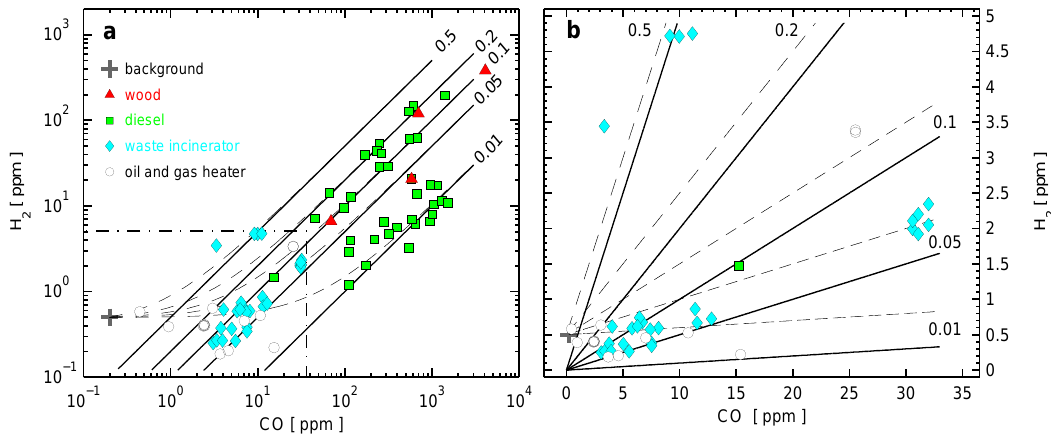
Fig. 1. Molecular hydrogen (H 2 ) versus carbon monoxide (CO) in combustion exhaust. All measurements are shown on a log-log scale in (a) and a selection (delimited by dashed-dotted box) on a linear scale in (b) . The H 2 and CO mole fractions in background air are shown as grey plus sign. Molar H 2 /CO ratio lines are shown as visual guides with the origins set at background mole fractions ( ∆ ratio, backgrounds subtracted, see text) shown as dashed lines and at zero mole fractions (absolute ratios, no background subtraction) as solid lines. (downstream of all filters) when our samples were